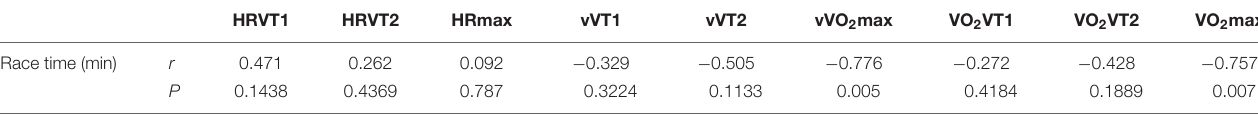
TABLE 4 | Pearson product-moment correlation coefficients between laboratory variables and race time.